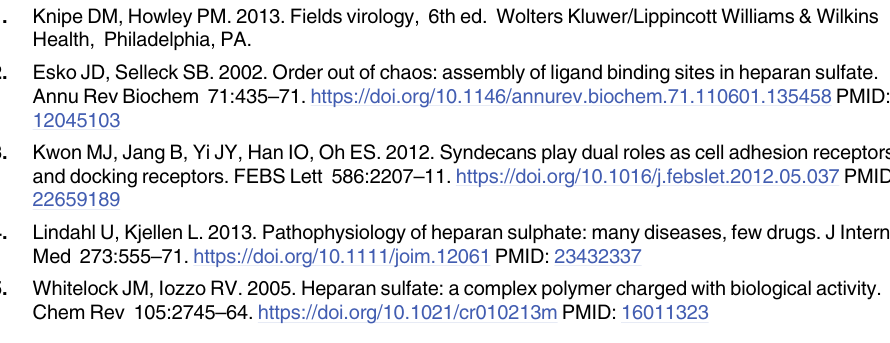
S2 Fig. Expression of NDST1-4 in B16/F10 cells. mRNA was extracted from untreated wild- type B16/F10 cells and used to synthesizes cDNA. Two different primer sets (corresponding to each previously reported NDST enzyme—NDST1, NDST2, NDST3, and NDST4) were then used to attempt to amplify regions of each gene from the cDNA. Successful PCR amplification was observed with both primer sets corresponding to NDST1 and NDST2. No specific PCR products were observed in either primer set against NDST3 or NDST4. Note that due to low technical quality the image shown has been enhanced for both brightness and contrast as well as cropped to remove irrelevant lanes on the right side. S3 Fig. Original scan of Actin western blot used in Fig 1B. Original scan of NDST western blot used in Fig